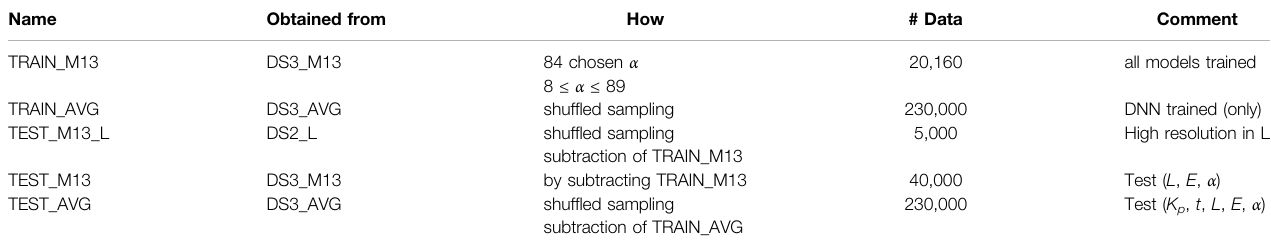
TABLE2| Thedatasetsusedfortraining(2 fi rstrows)andtesting(3lastrows).Testdataareobtainedbysubtractingthetrainingandvalidationdatasetsfromthedata,andall points that are outside the bounds of these training and validation datasets, so as to avoid extrapolation in the